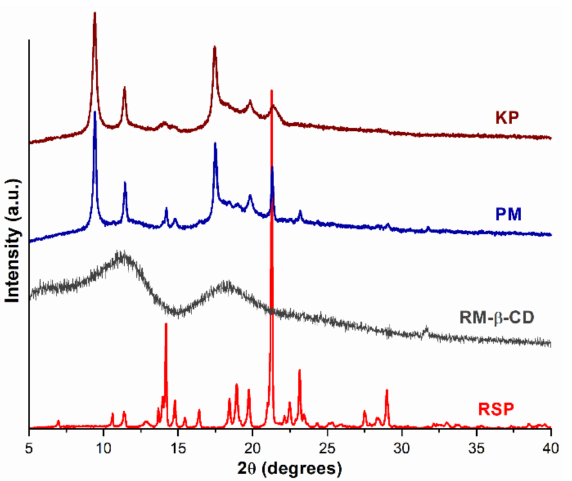
Figure 5. Powder X-ray diffractometry (PXRD) pattern of RSP, RM- β -CD, and RSP/RM- β -CD binary products physical mixture (PM) and kneaded product